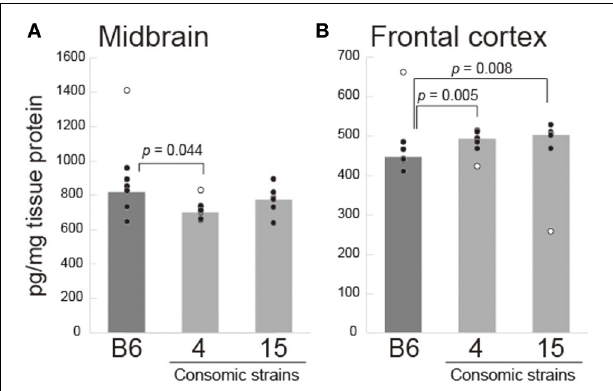
FIGURE 7 | Brain 5-HT content (pg/mg tissue) in the midbrain (A) and prefrontal cortex (B) in B6 and consomic strains of Chr 4 and Chr 15. Each circle indicates each individual’s 5-HT content, and open circles indicate outliers that were excluded for statistical analysis. The p -values were calculated by t -test with Bonferroni